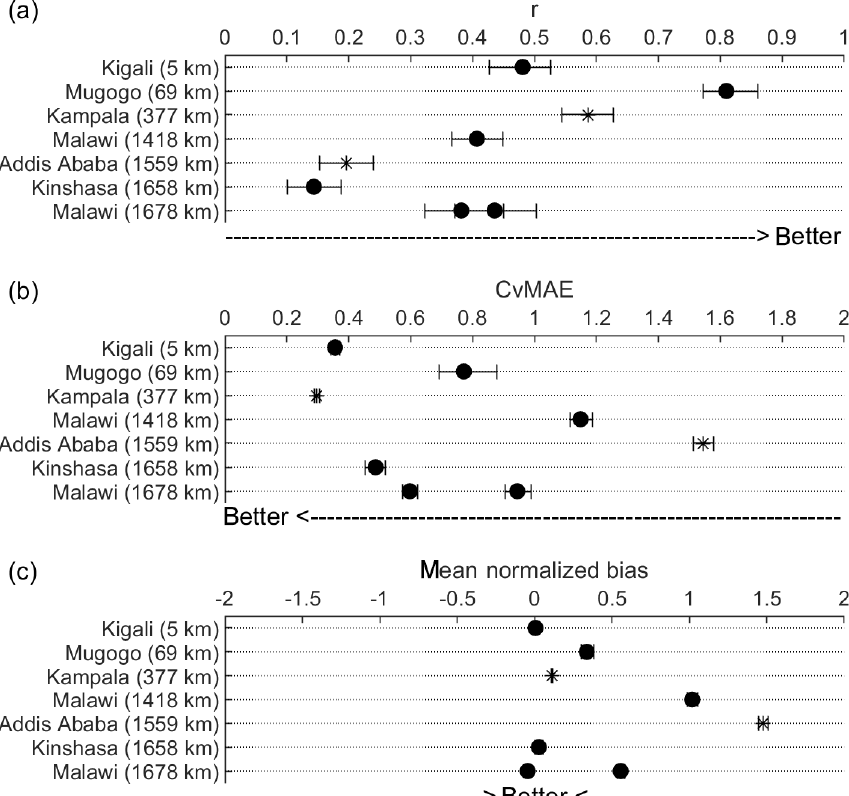
Figure 9. Comparison of performance metrics ( a correlation, b CvMAE, c MNB) for surface PM 2 . 5 estimated from satellite AOD data across multiple sites in SSA. The conversion factor is developed at a central site in Kigali, Rwanda; the distances of each testing site to this central site are given. Performances are assessed for all data collected at the given sites using the prior conversion factor only. Note that performance in Kampala and Addis Ababa is assessed using traditional reference monitors (indicated by ∗ ), while performance at the other sites reflects low-cost sensor data (indicated by • ). Error bars denote the interquartile range of metric estimates obtained via bootstrap resampling (for most cases of the mean normalized bias, this range is smaller than the marker